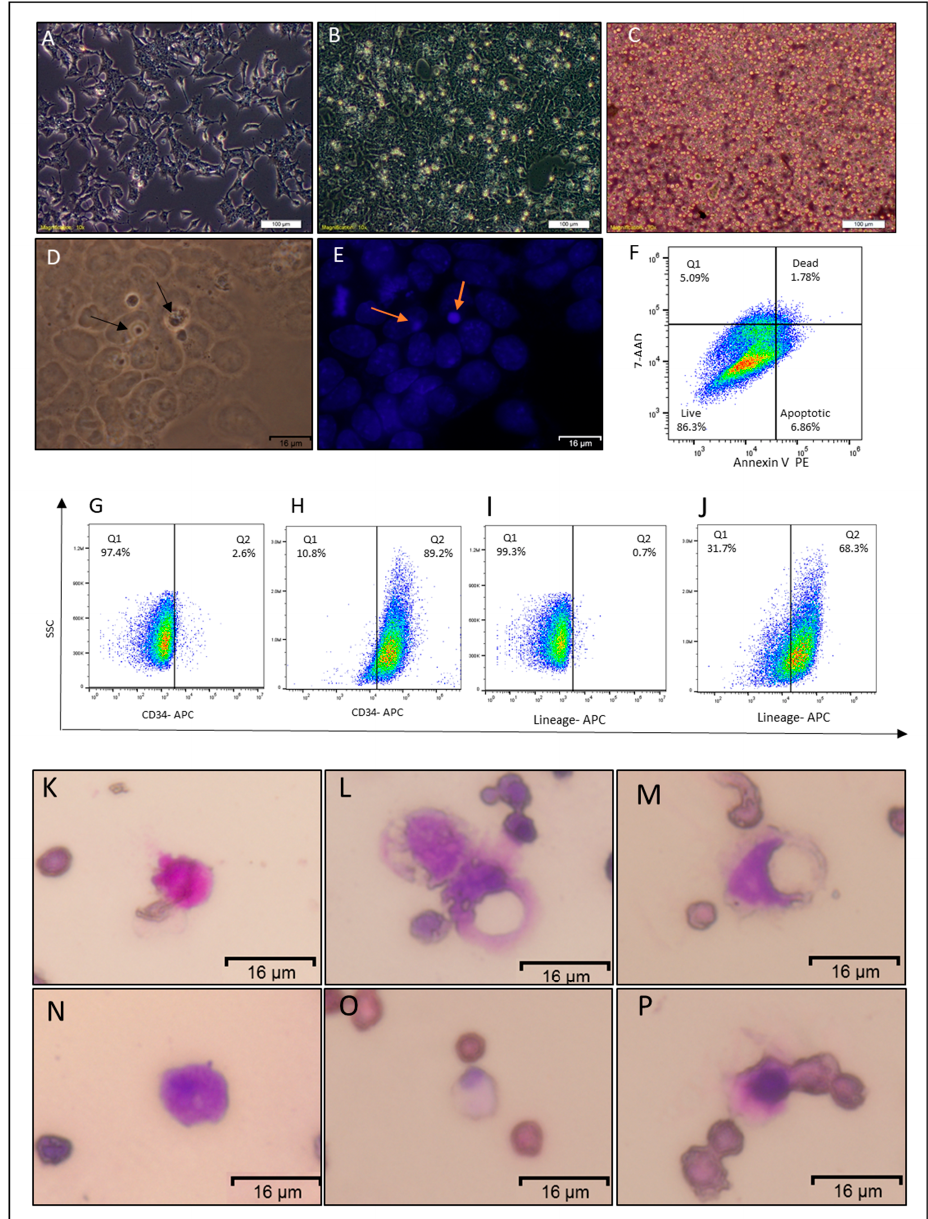
Figure 2. Characterization of the non-adherent round cells. ( A ) Representative image of CSCcmBT549 after 24 h of seeding. ( B ) Representative images of CSCcmBT549 cells after 72 h of seeding, showing round non-adherent cells on the top of the monolayer of adherent cells. ( C ) Floating non-adherent cells collected from the culture of CSCcmBT549 cells. Scale bars for ( A , B , C ) represent 100 µ m. ( D , E ) Bright field and DAPI staining showing nuclei of round non-adherent cells (NACs) on the top of the monolayer adherent cells. Scale bars represent 16 μ m. ( F ) Representative image of flow cytometry analysis of apoptosis assay by” Annexin V and 7-AAD kit” shows that the majority of the cells are viable while apoptotic and dead cells are less than 15%. This image is representative of at least three independent experiments. ( G – J ) Flow cytometry analysis for CD34 and hematopoietic lineage di ff erentiation markers (Lineage Cell Detection Cocktail-Biotin, where ( G , I ) are for adherent CSCcmBT549 cells and ( H , J ) are for NACs. Each result is shown as a representative of at least three independent experiments. ( K – P ) Wright–Giemsa staining of floating cells showing di ff erent diameters and staining patterns. Scale bars represent 16 µ